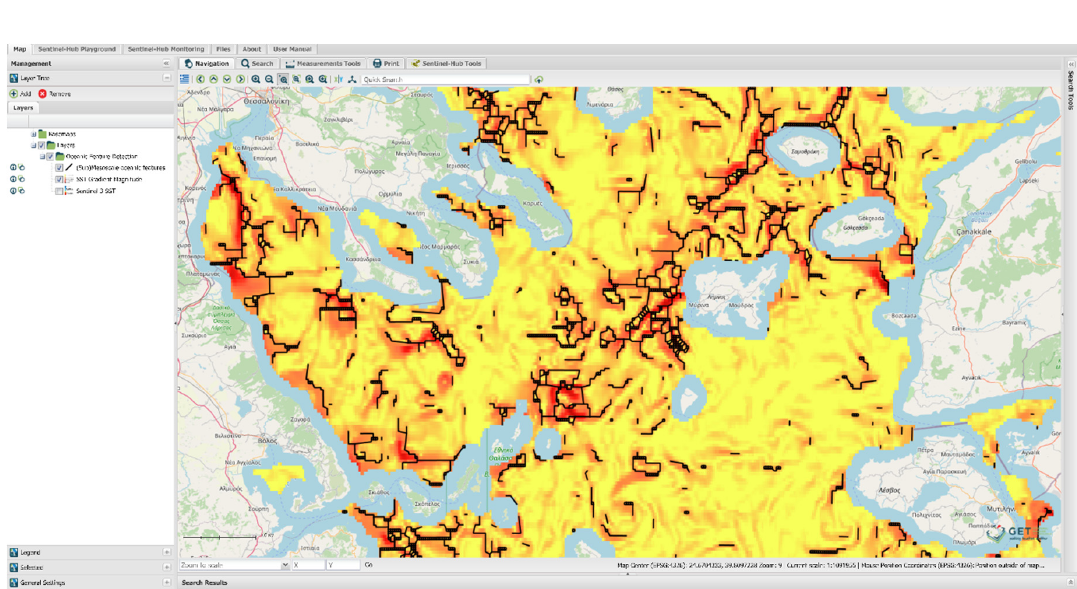
Figure 7. Preview of the webGIS application interface. The application can be accessed through the URL: http://mrsg ‐